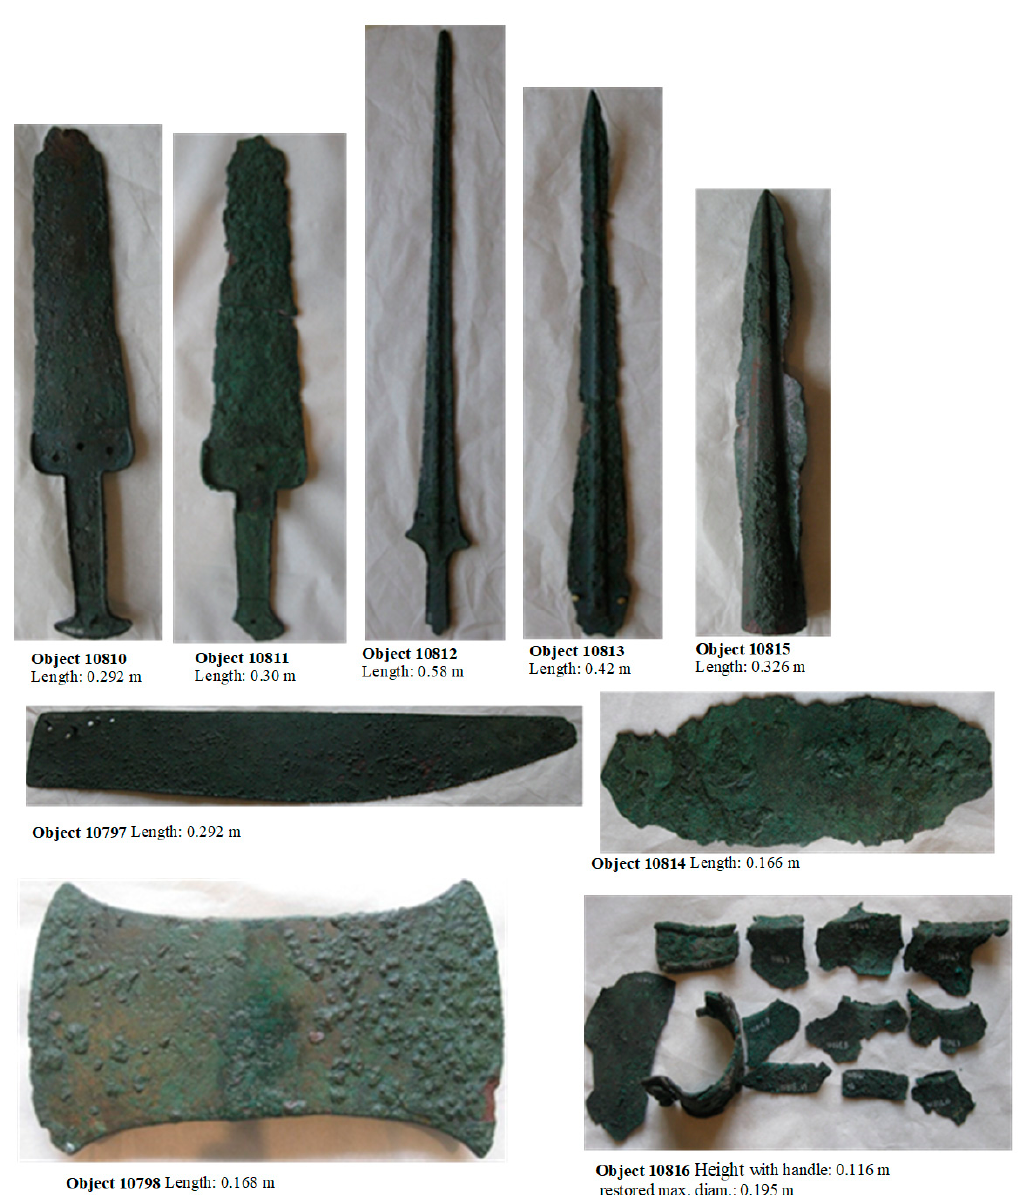
Figure 2. Nine copper-based objects (a saw, a double axe, daggers, swords, a razor, a spearhead and a bowl in fragments) originated from Euboea—the “Andronianoi hoard”—Nos. 10797, 10798, 10810–10816, dated back at the LBA (15th–12th century BC).